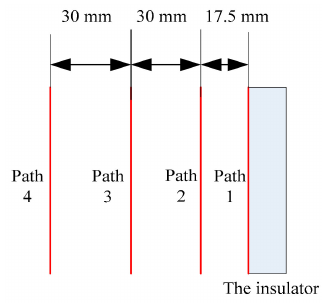
Figure 9. The schematic diagram of path 1, 2, 3, 4.